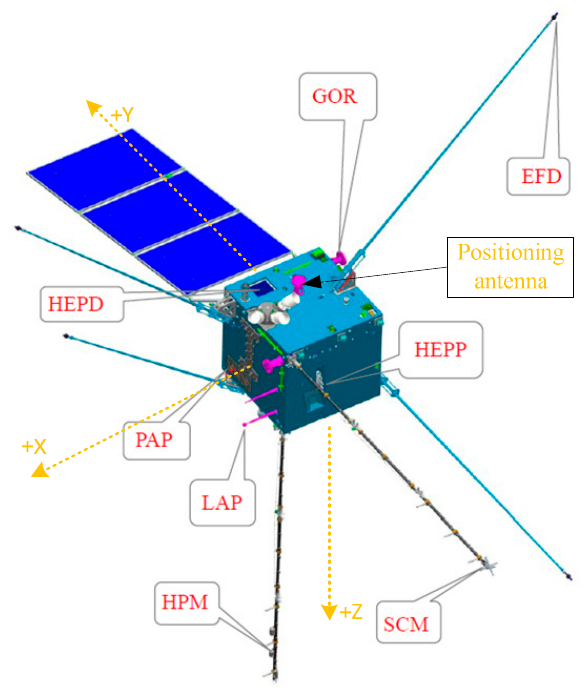
Figure 1. China Seismo-Electromagnetic Satellite (CSES) platform.